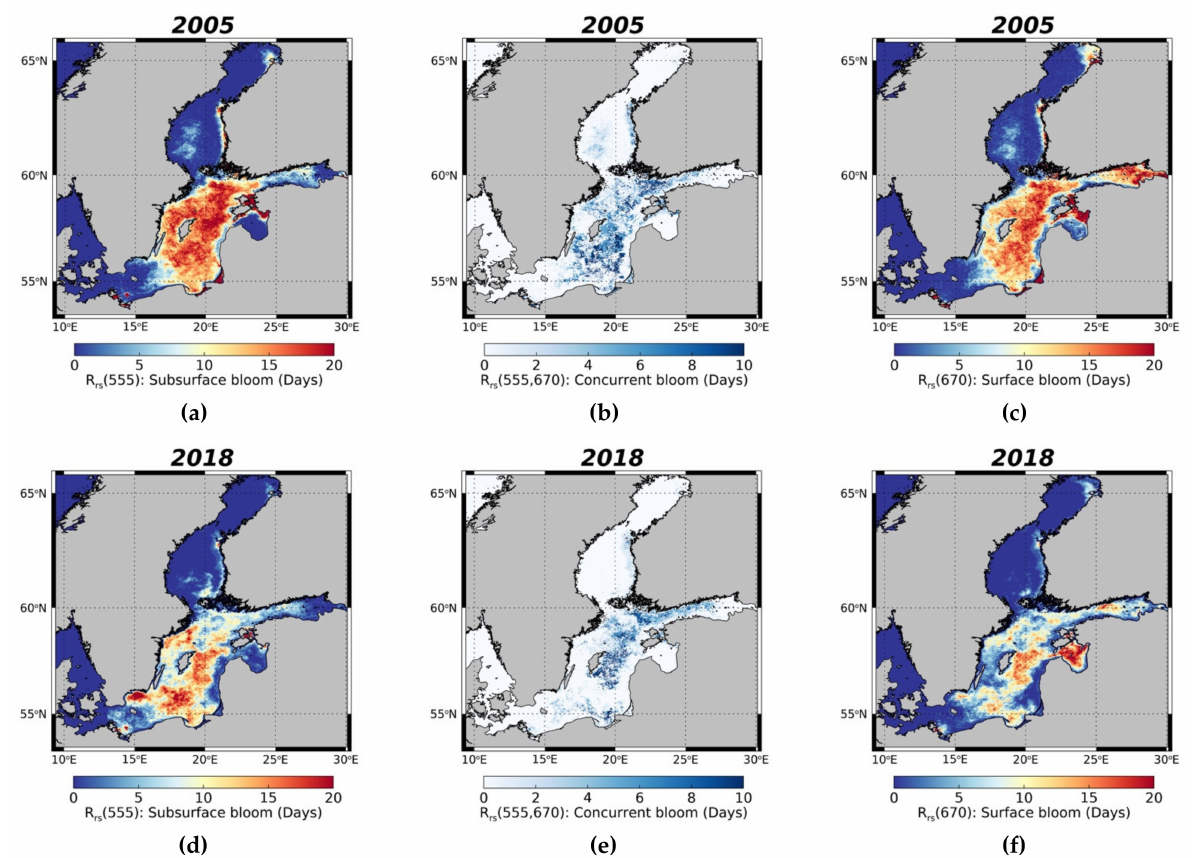
Figure 11. Summer bloom spatio-temporal coverage for 2005 and 2018. ( a ) Subsurface bloom for 2005, ( b ) concurrent sub-scheme 2005, ( c ) surface bloom for 2005, ( d ) subsurface bloom for 2018, ( e ) concurrent subsurface and surface bloom for 2018, and ( f ) surface bloom for